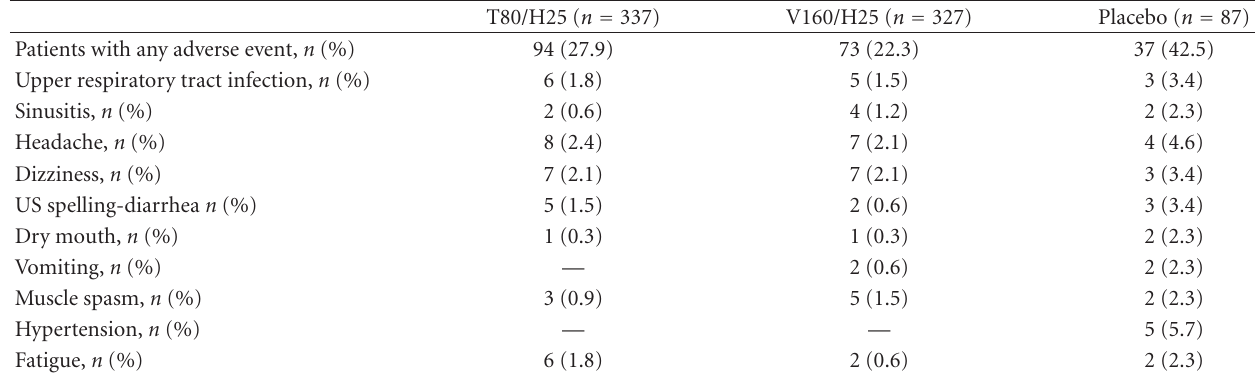
Table 3: Adverse events with incidence ≥